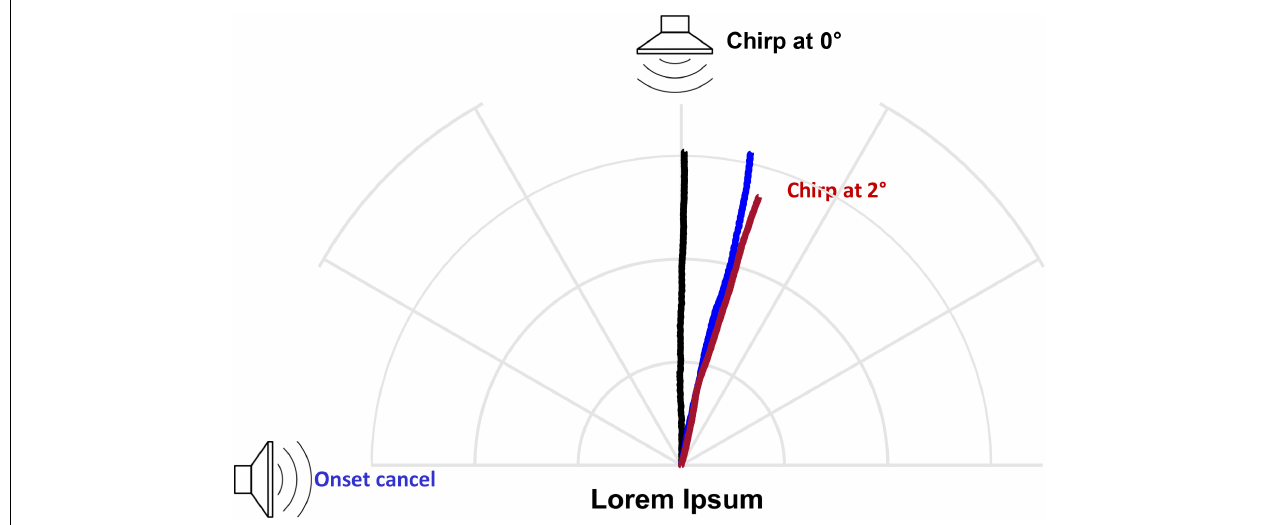
FIGURE 9 | Comparison with free-field auditory directionality. The directional effect of onset cancelation corresponded to a source azimuth of 2 ◦ . Chirp at 0 ◦ vs. onset cancel: n = 5 flies, 10 runs/fly/angle, Watson’s U = 0.4607, p < 0.001. Grid = 1